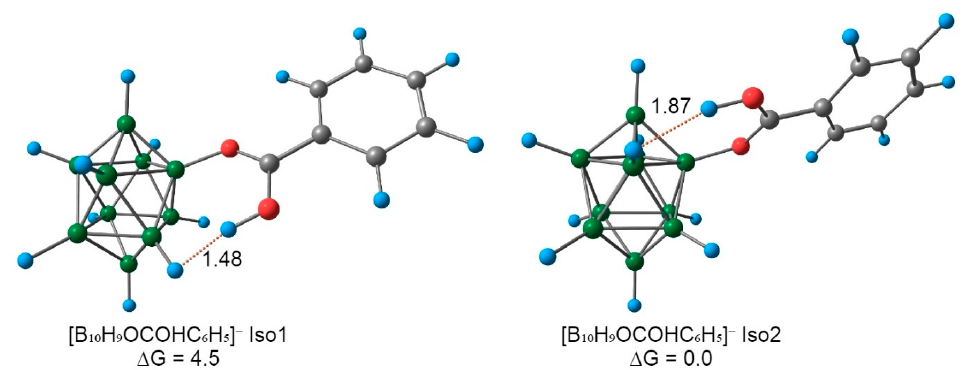
Figure 5. The structure of main isomers of [B 10 H 9 OC(OH)C 6 H 5 ] − anion. Length units—Å, energy units—kJ/mol, ω B97X-D3/def2-TZVPP level of theory.